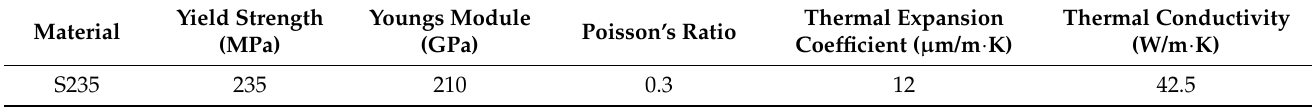
Table 3. Material properties used in